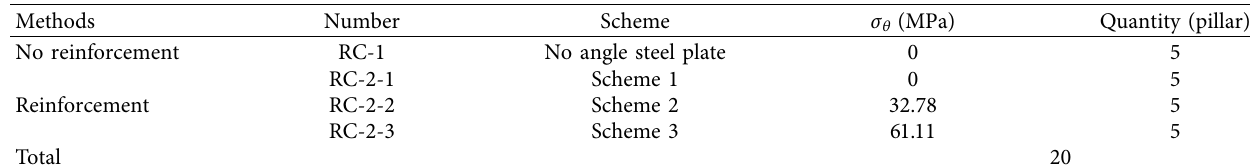
Figure 3: Stress diagram after reinforcement. (a) Column section. (b) Angle plate plane stress. (c) Stereoscopic loading of angle plates. (d) Section overall stress. (e) Protective layer stress. (f) Force of Table 1: Details of specimens.